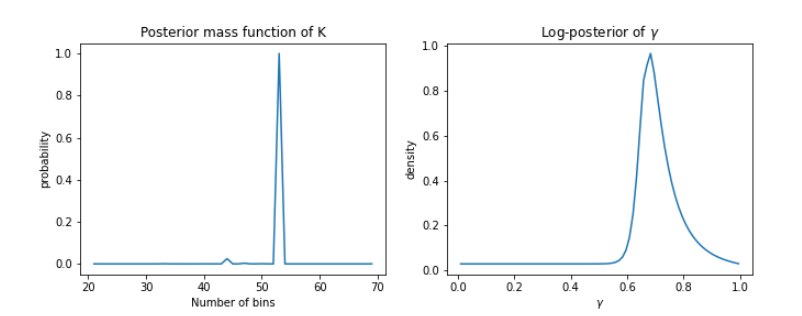
Figure 2. Posteriors of number of bins ( left ) and of γ ( right